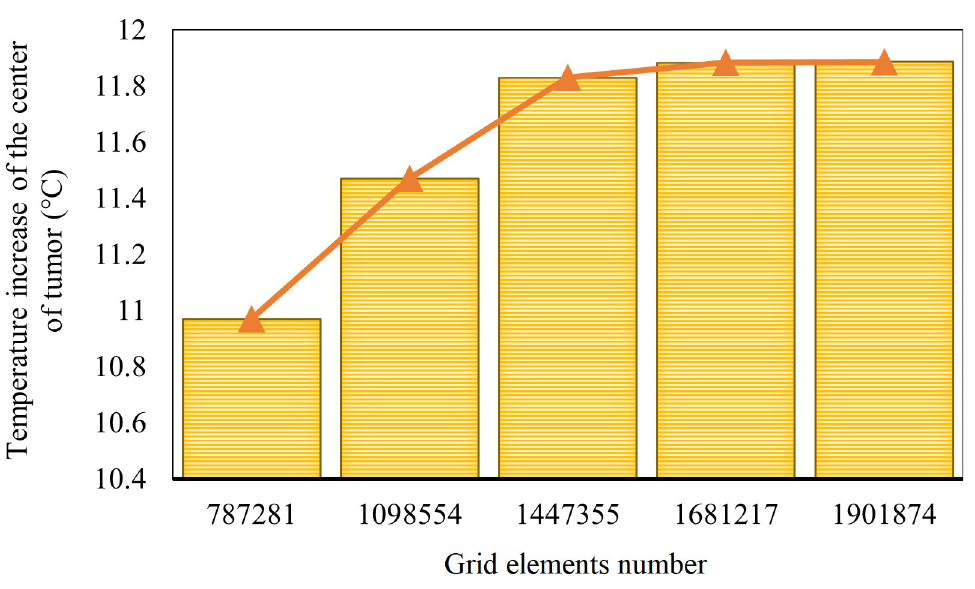
Fig 8. Grid independency test in the present study.